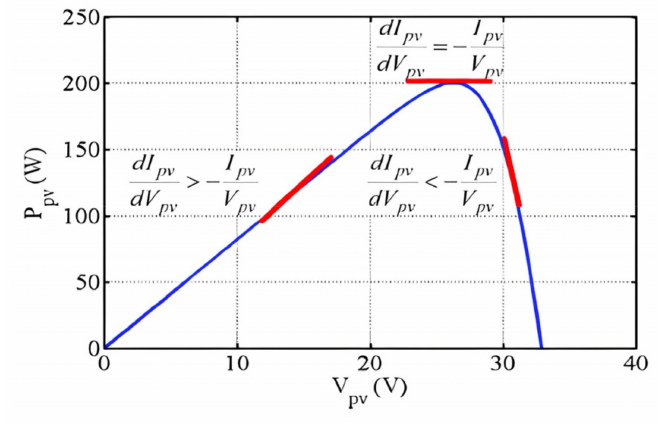
Figure 13. Slope at various regions of the PV curve